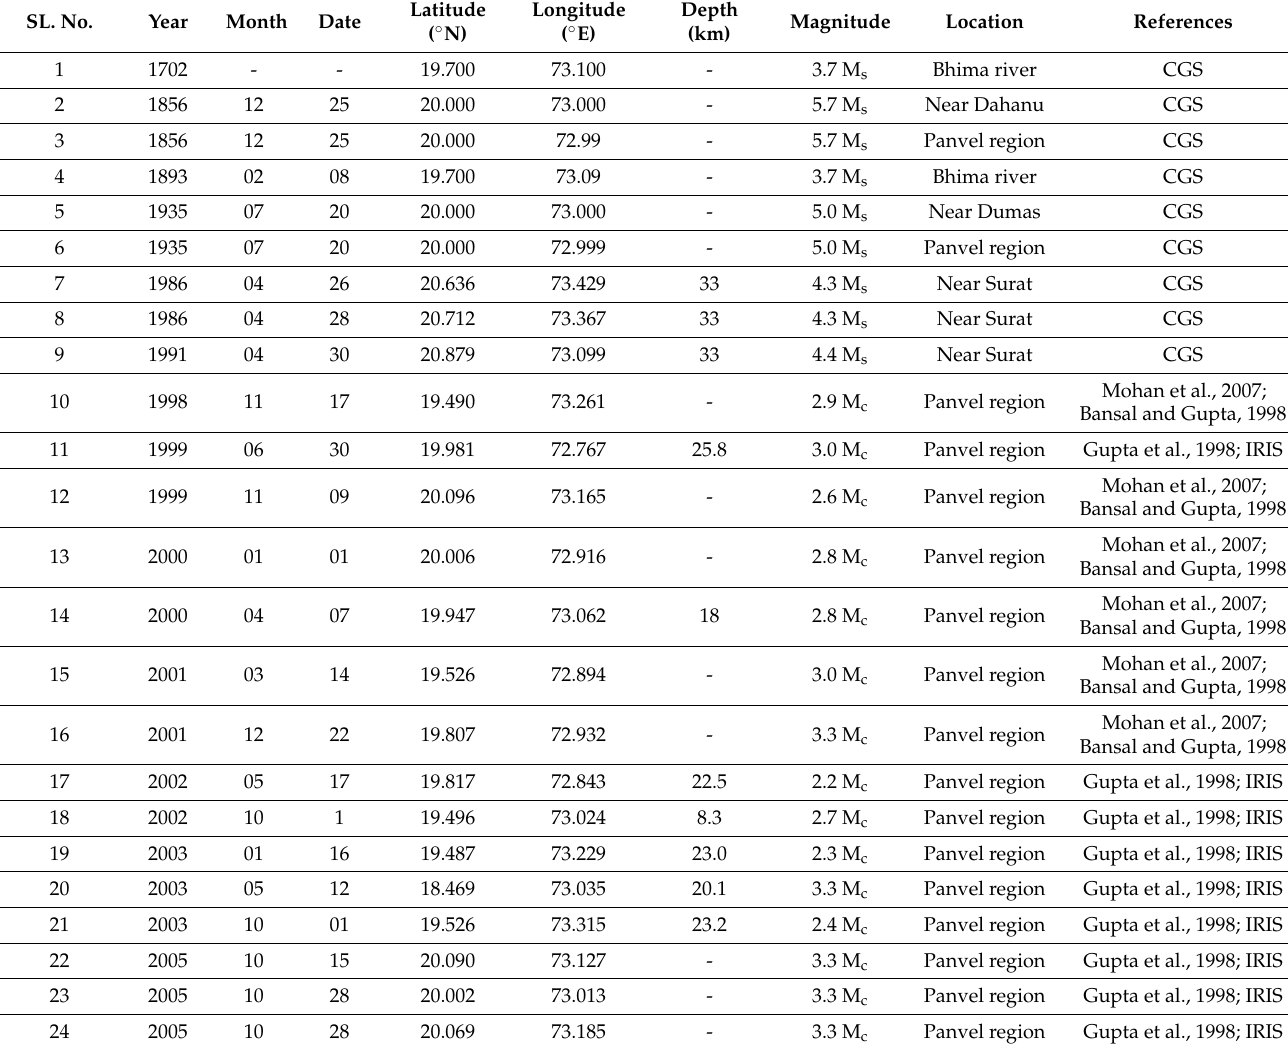
Table A1. List of past earthquakes that occurred in the study area from